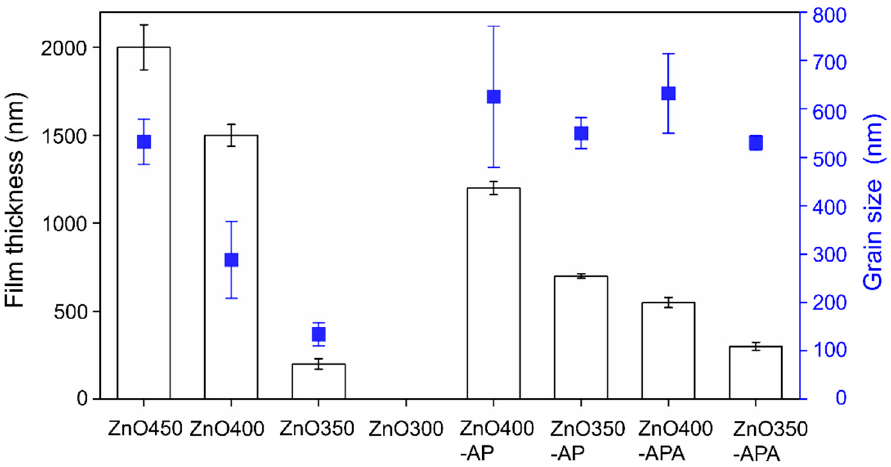
Figure 5. Thickness and grain sizes of ZnO of various processing conditions.